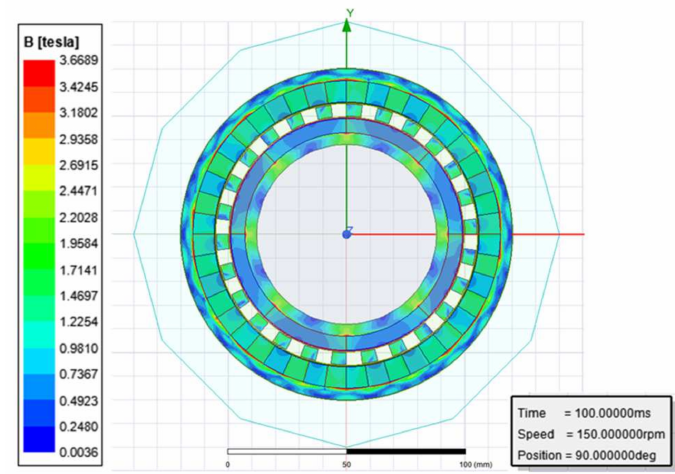
Figure 7. Magnetostatic field.